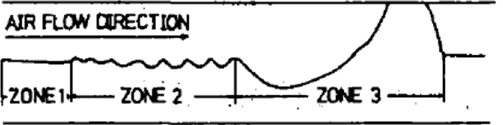
Figure 3. Conceptional view of the slug initiation (Ansari and Nariai [36]).